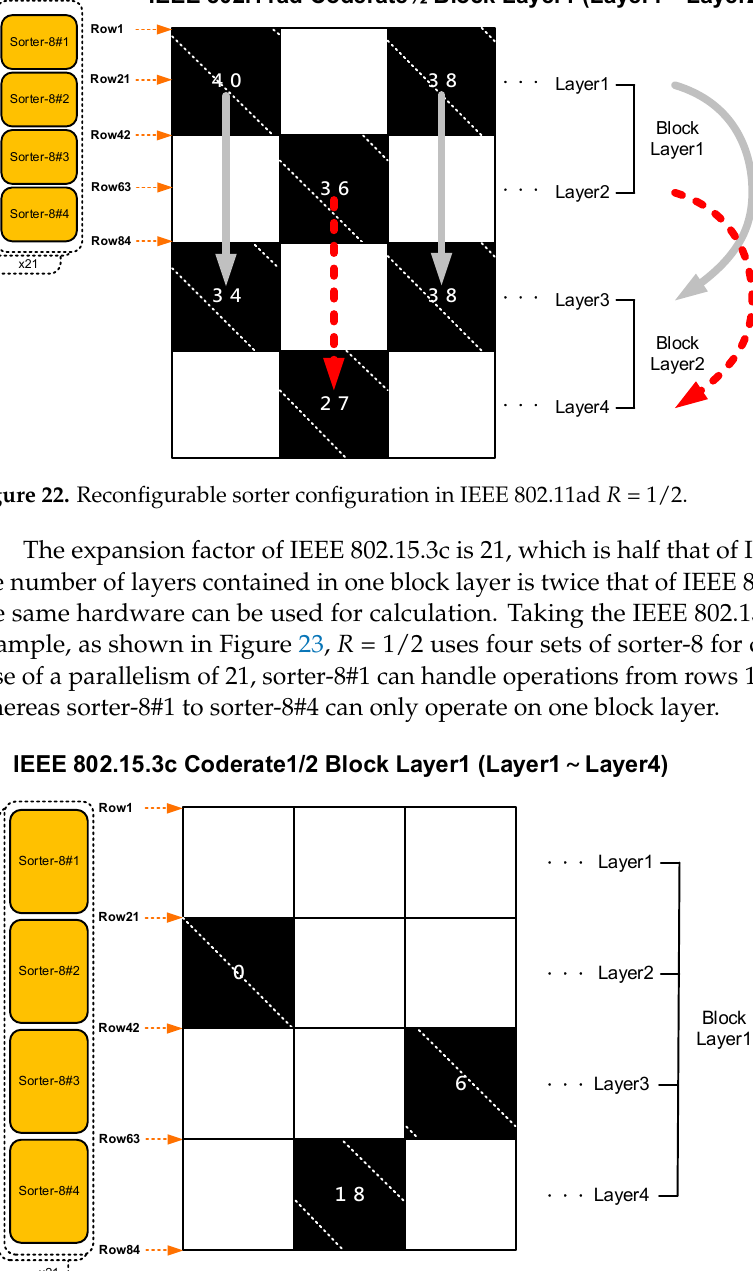
Figure 21. Reconfigurable 8/16/32 input sorter architecture.